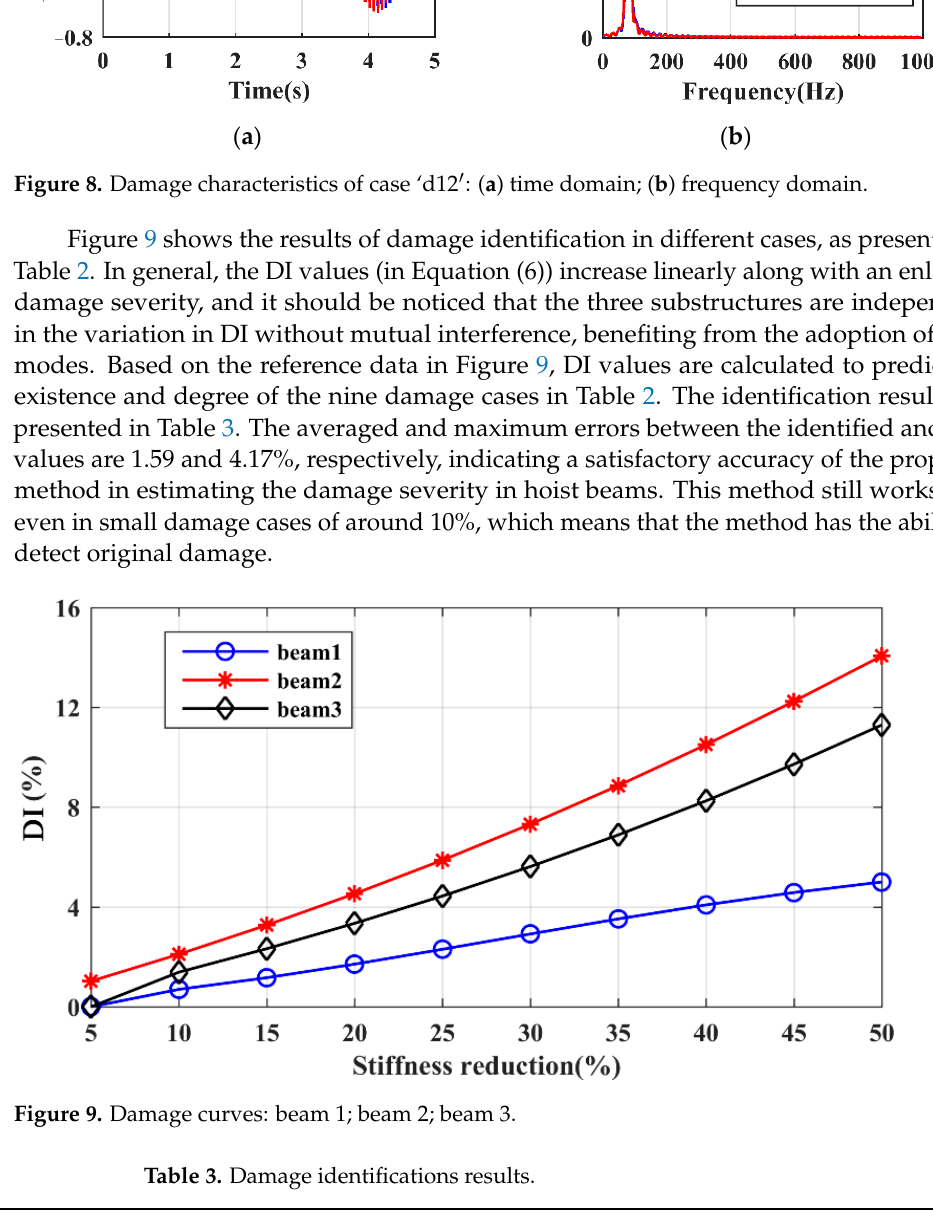
Figure 8. Damage characteristics of case ‘d12 ′ : ( a ) time domain; ( b ) frequency domain.